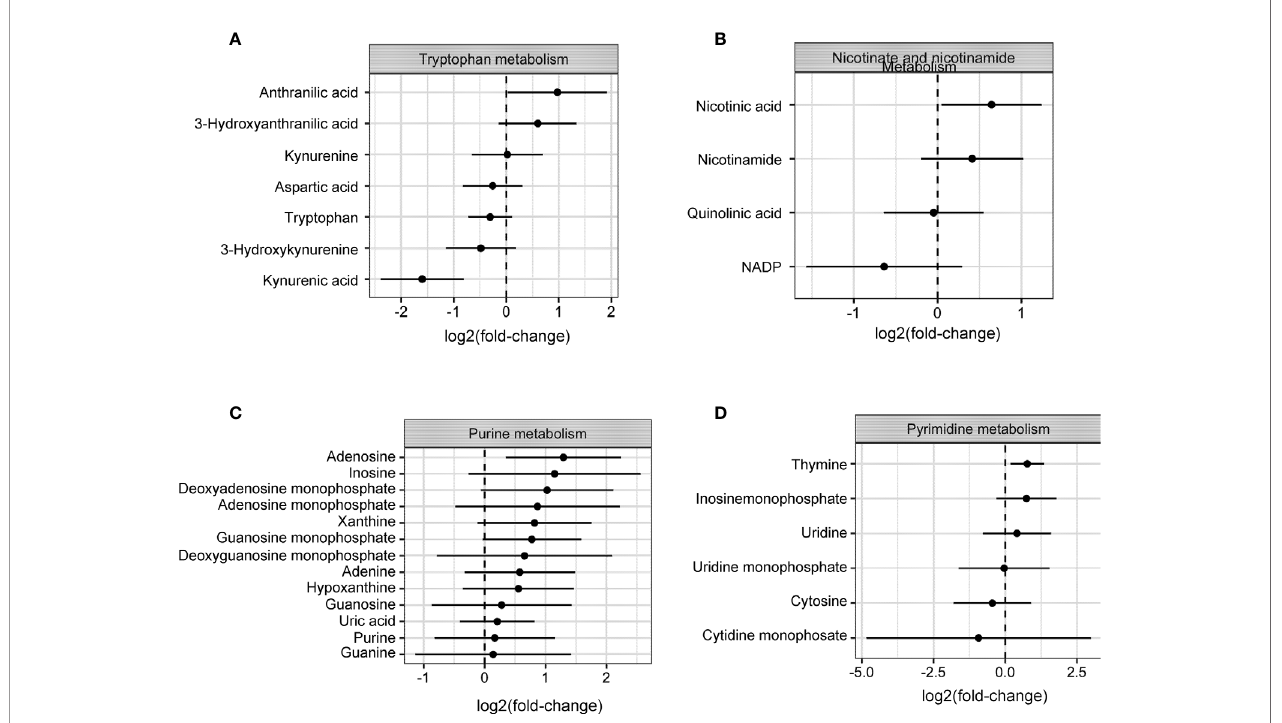
FIGURE 2 | Metabolites levels from the kynurenine, nicotinamide, purine and pyrimidine metabolic pathways are affected by IDO1 expression by the tumor. On Day 28 of tumor progression, whole tumor was harvested from IE9mp1-mIDO1 (n=4) and IE9mp1-Empty Vector control (n=4) tumor-bearing mice. On Day 47 of tumor progression, whole tumor was harvested from IE9mp1-mIDO1 (n=4) and IE9mp1-Empty Vector control (n=5) tumor-bearing mice. Mean log 2 fold changes in metabolites from (A) tryptophan amino acid degradation, (B) NAD, (C) purine and (D) pyrimidine metabolism pathways measured in IE9mp1-mIDO1 and IE9mp1-EV tumor from WT C57BL/6 mice on Days 28 and 47. These data presented are the relative abundance measurements of the metabolite level and sample t test statistical analysis reveals the 95% con fi dence interval of the mean log-fold change in metabolites. The p-values of all the metabolites are listed in Supplemental Table 1 .